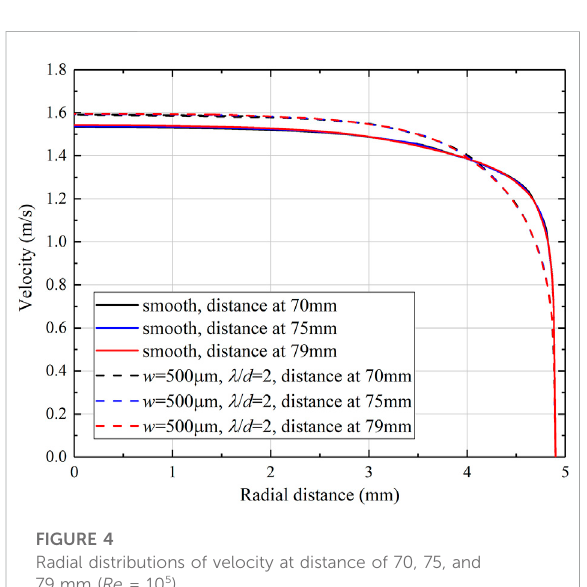
FIGURE 4 Radial distributions of velocity at distance of 70, 75, and 79 mm ( Re = 10 5 ).